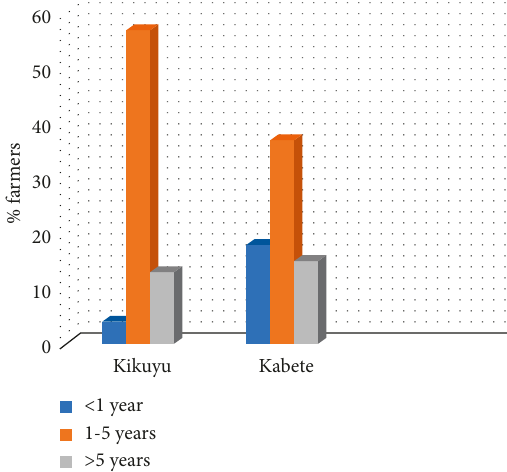
Figure 6: Number of years in keeping poultry by